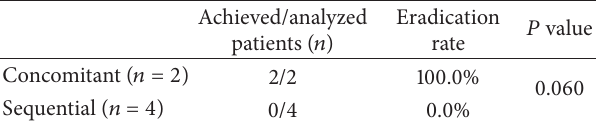
Table 4: Third-line eradication rates of Helicobacter pylori